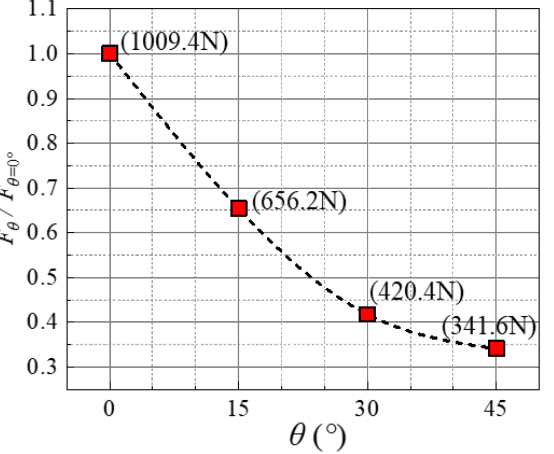
Figure 5. Maximum impact force under different baffle angle conditions, normalized with the maximum impact force of the baffle with θ = 0°.